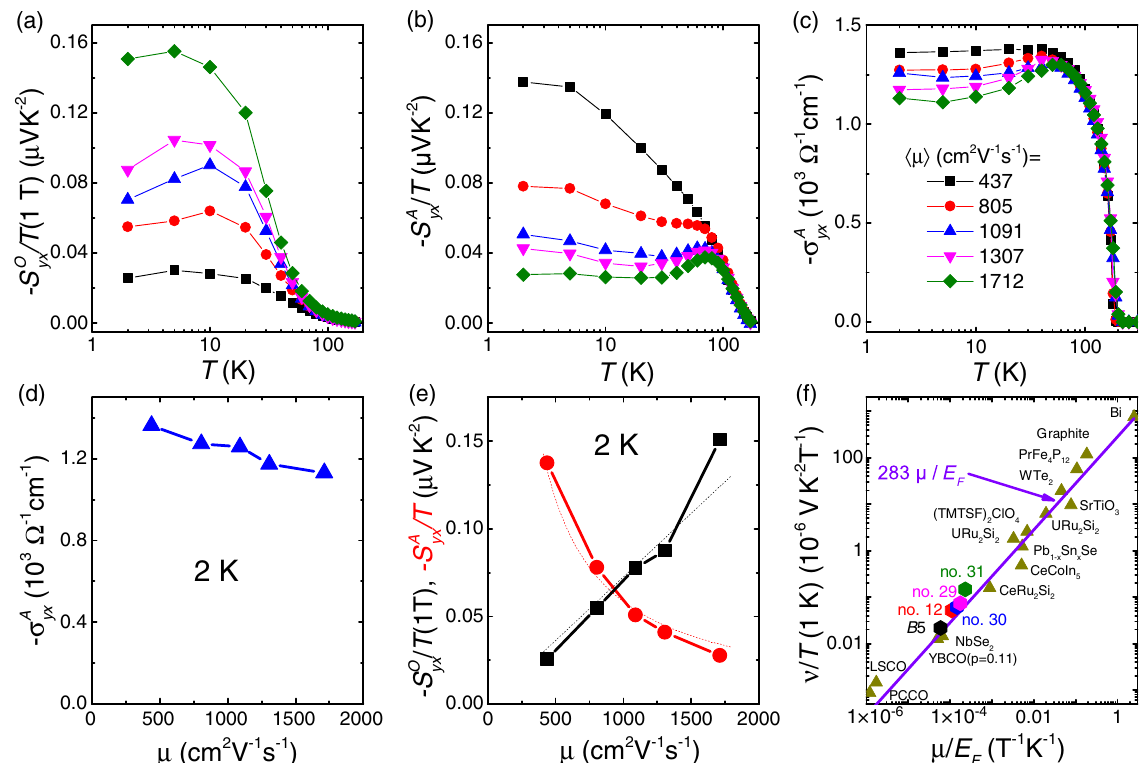
FIG. 4. Opposite evolution of ordinary and anomalous Nernst effects with disorder. Temperature dependence of the ordinary Nernst effect S O yx =T (a), the anomalous Nernst effect S A yx (b), and the anomalous Hall conductivity σ A yx (c) in five different samples with different mobilities as defined in (a). (d) Low-temperature AHC modestly decreases with increasing mobility. (e) Variation of S O yx and S A yx with mobility. The first is proportional to mobility (dashed black line), but the second proportional to the inverse of mobility (dashed red line). (f) The ordinary Nernst coefficient ν ¼ S O xy =B at 2 K compared with other solids. The solid line represents the amplitude expected in the semiclassical picture ( ν =T ¼ ð π 2 = 3 Þð k B =e Þð μ =E F Þ )